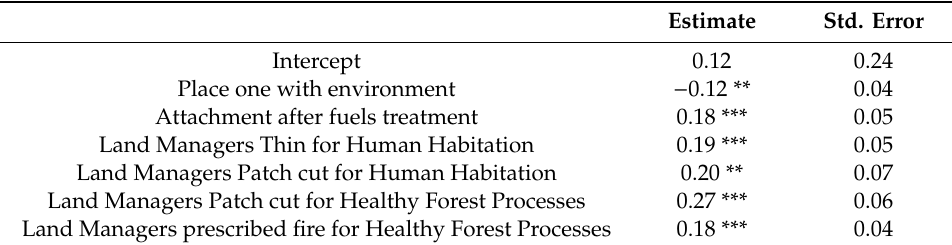
Table 7. Results of stepwise regression for support for the Forsythe II